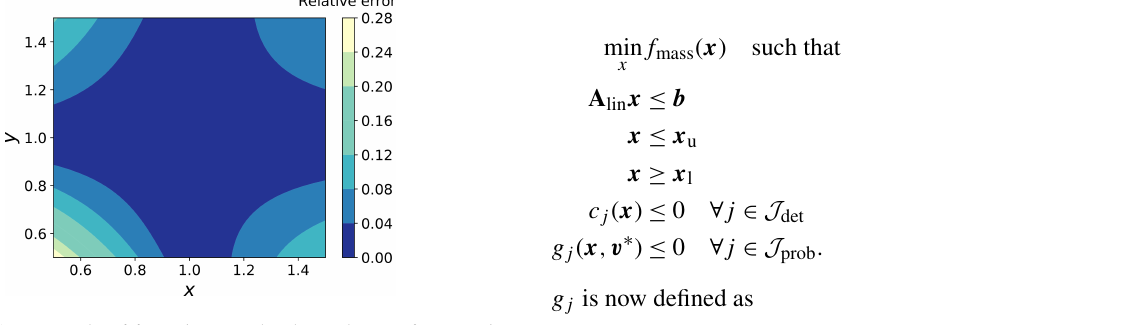
Figure 3. An example of factoring out the dependence of one vari- able from a non-separable expression by using GPR to fit this un- known factor. The figure shows the relative error when approximat- ing ( x + y ) 2 as f ( y )( x + 1) 2 , around x = 1, with f (1) = 1 and oth- erwise unknown. Note the accuracy of this representation around (1,1) and in general the moderate error level as we move away from this